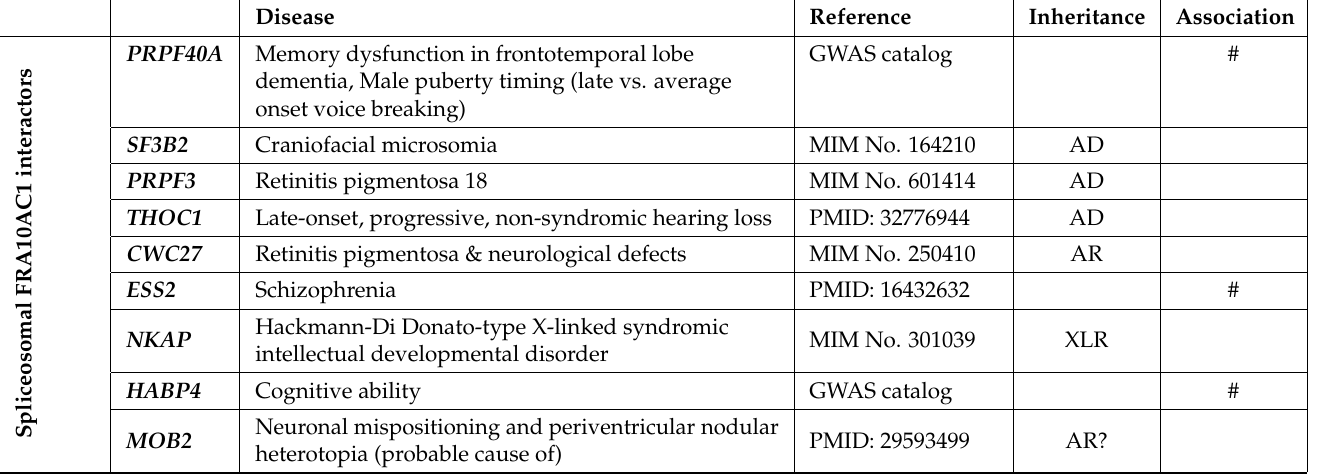
Figure 4. Reconstruction of the FRA10AC1 PPI network. The first neighbors of FRA10AC1 and any interactions between them are shown. “Yellow” nodes represent proteins being characterized as spliceosomal components. “Turquoise” proteins represent FRA10AC1 interactors not involved in pre-mRNA processing (non-spliceosomal). The network is enriched with five disease-causative proteins, shown in orange, interconnected with at least two “turquoise” FRA10AC1 interactors. “Diamond” and “triangle” nodes correspond, respectively, to disease-causative and disease-associated proteins. Table 1. Disease-causative and disease-associated genes in FRA10AC1